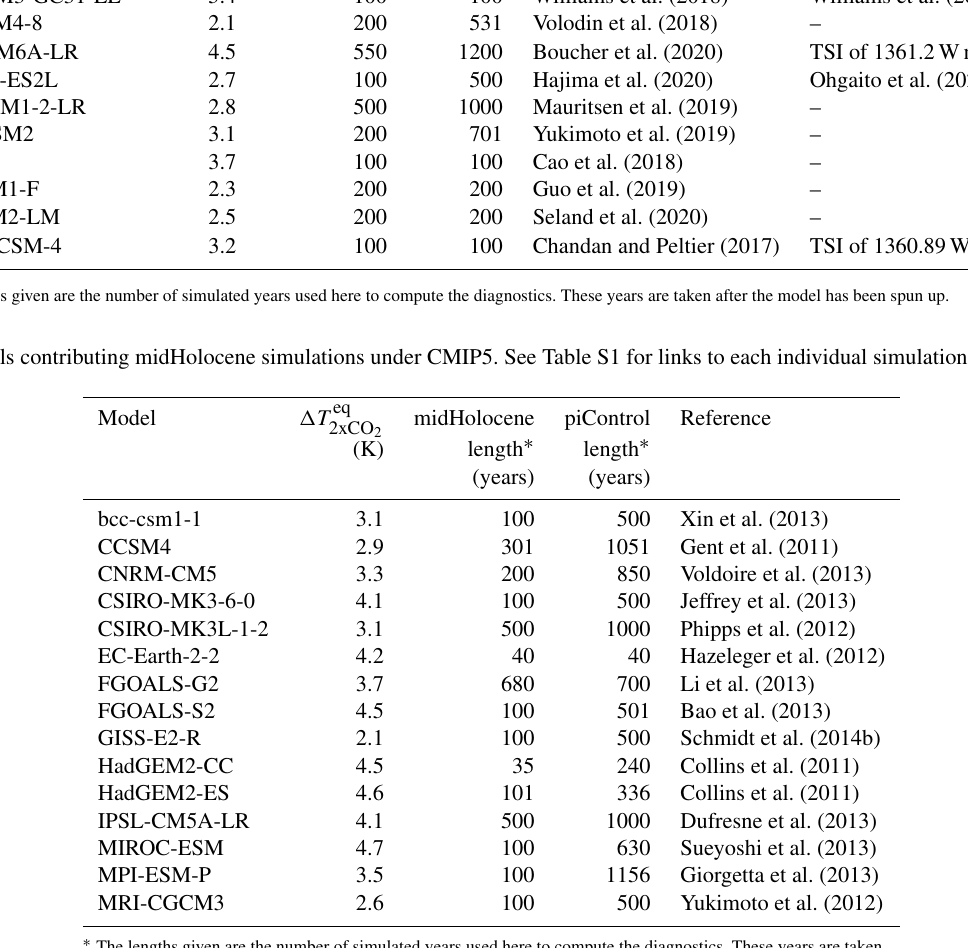
NESM3 NorESM2-LM